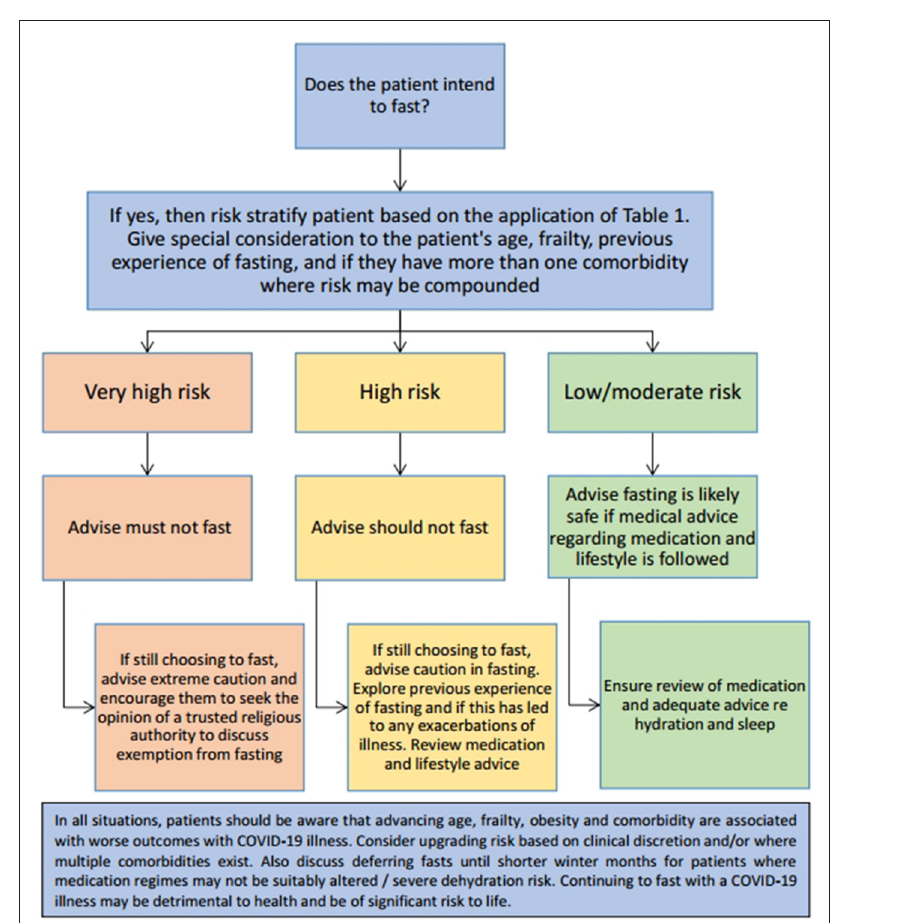
Figure 1 Decision making tool for those fasting with chronic